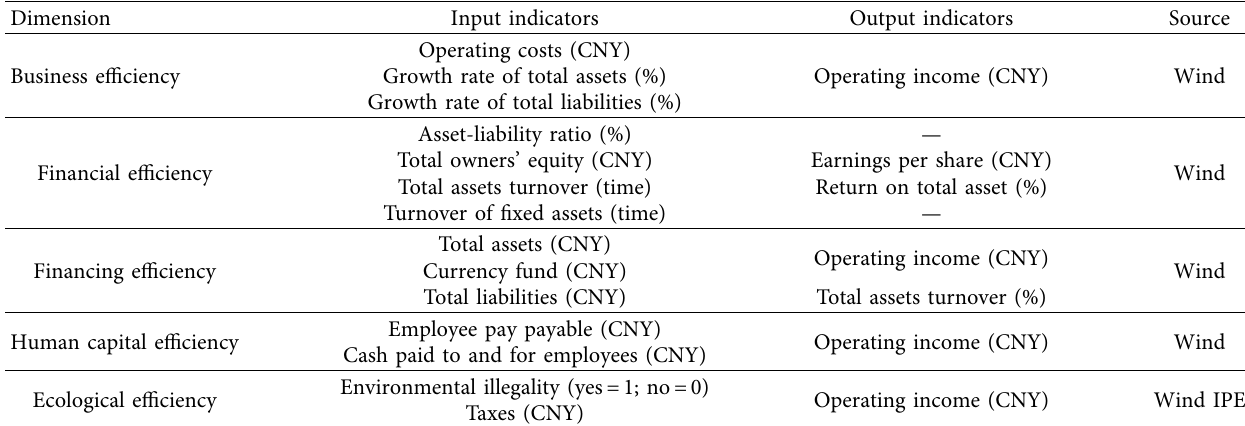
Table 1: System of input-output